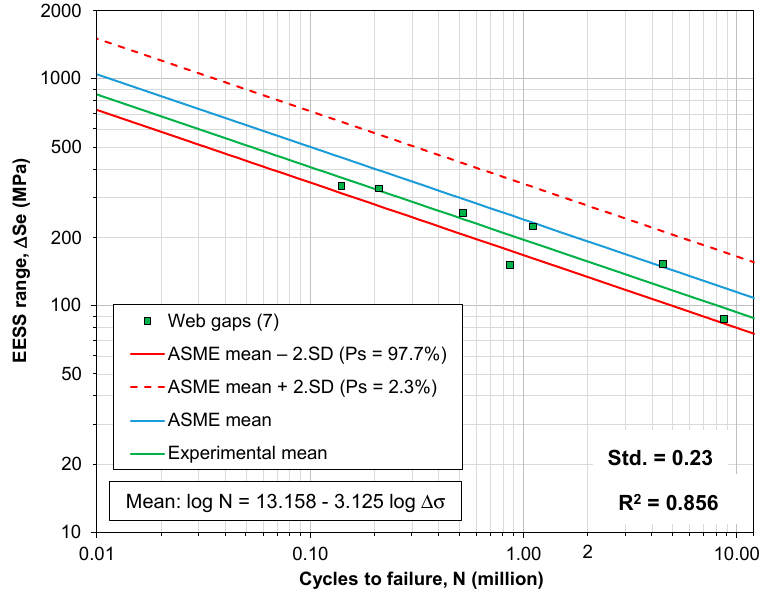
Figure 16. Master S-N curve for welded bridge details.